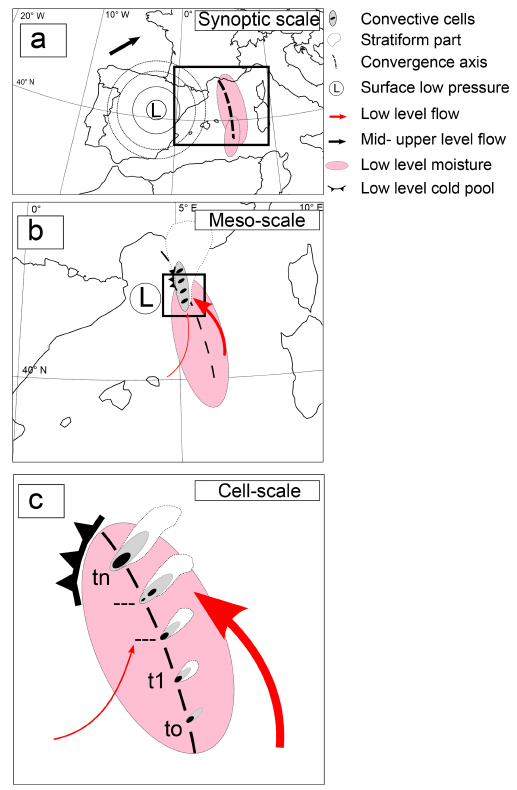
Figure 16. Schematic drawings of the precipitation structures of the convective systems and triggering ingredients observed during HyMeX IOP16a on 26 October 2012, at the (a) synoptic scale, (b) mesoscale, and (c) cell scale,